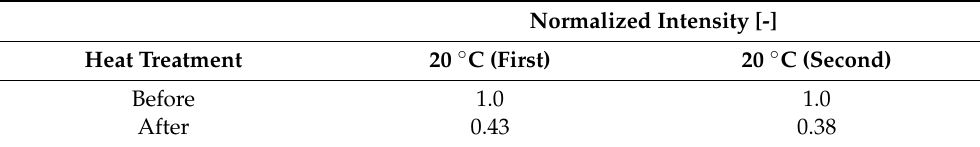
Table 1. Normalized luminescence intensity of PC-PSP before and after the heat treatment at 20 ◦ C (first and second) and 100